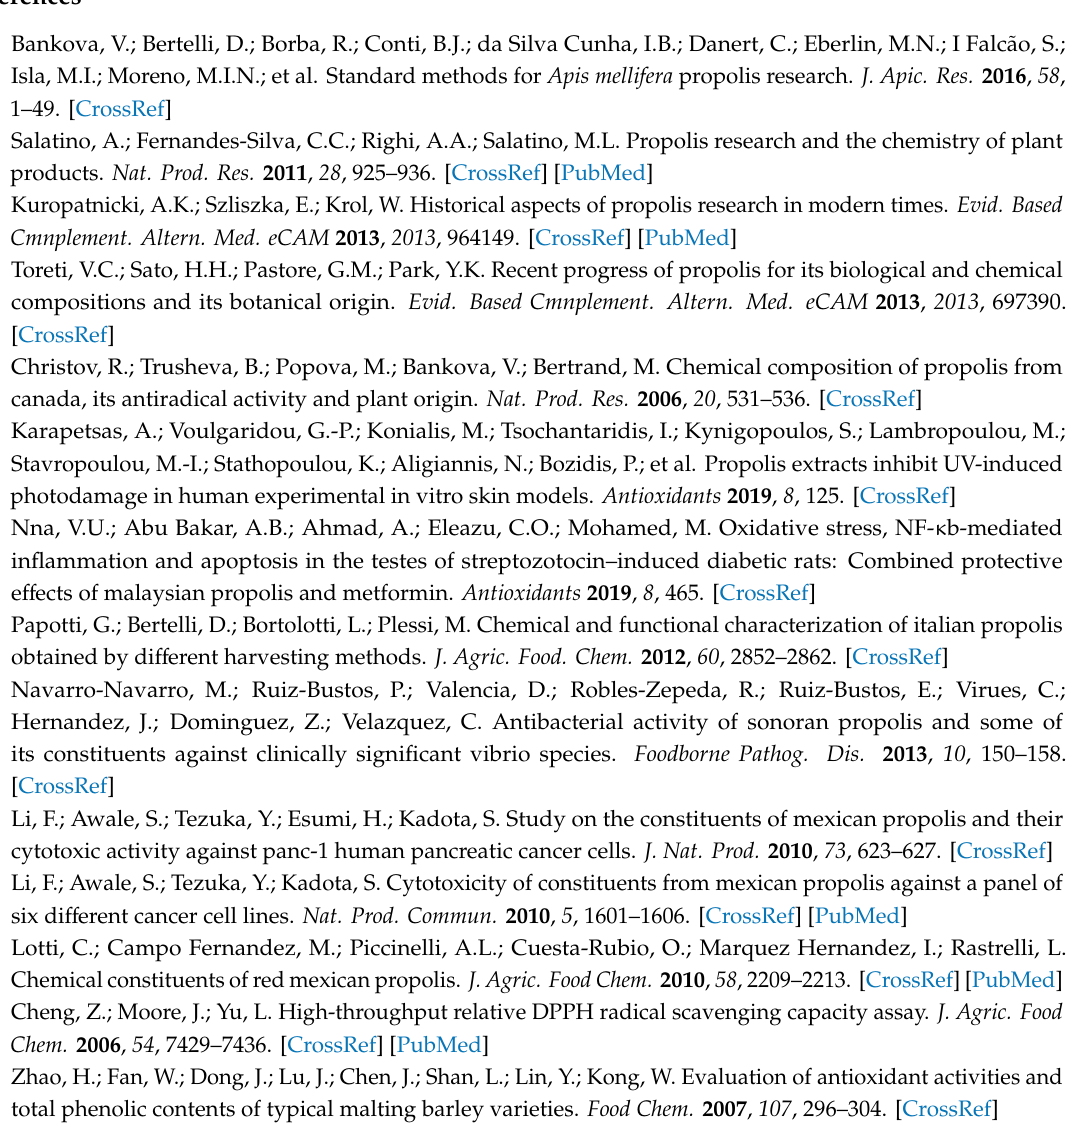
GUA-4; Figure S3: Major volatile compounds of EEP GUA-4; Table S1: 1 H-RMN data of the flavonoids isolated from Mexican